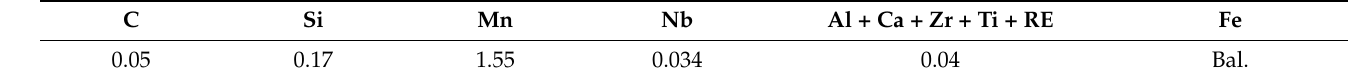
Table 1. Chemical composition of the tested steel (wt,